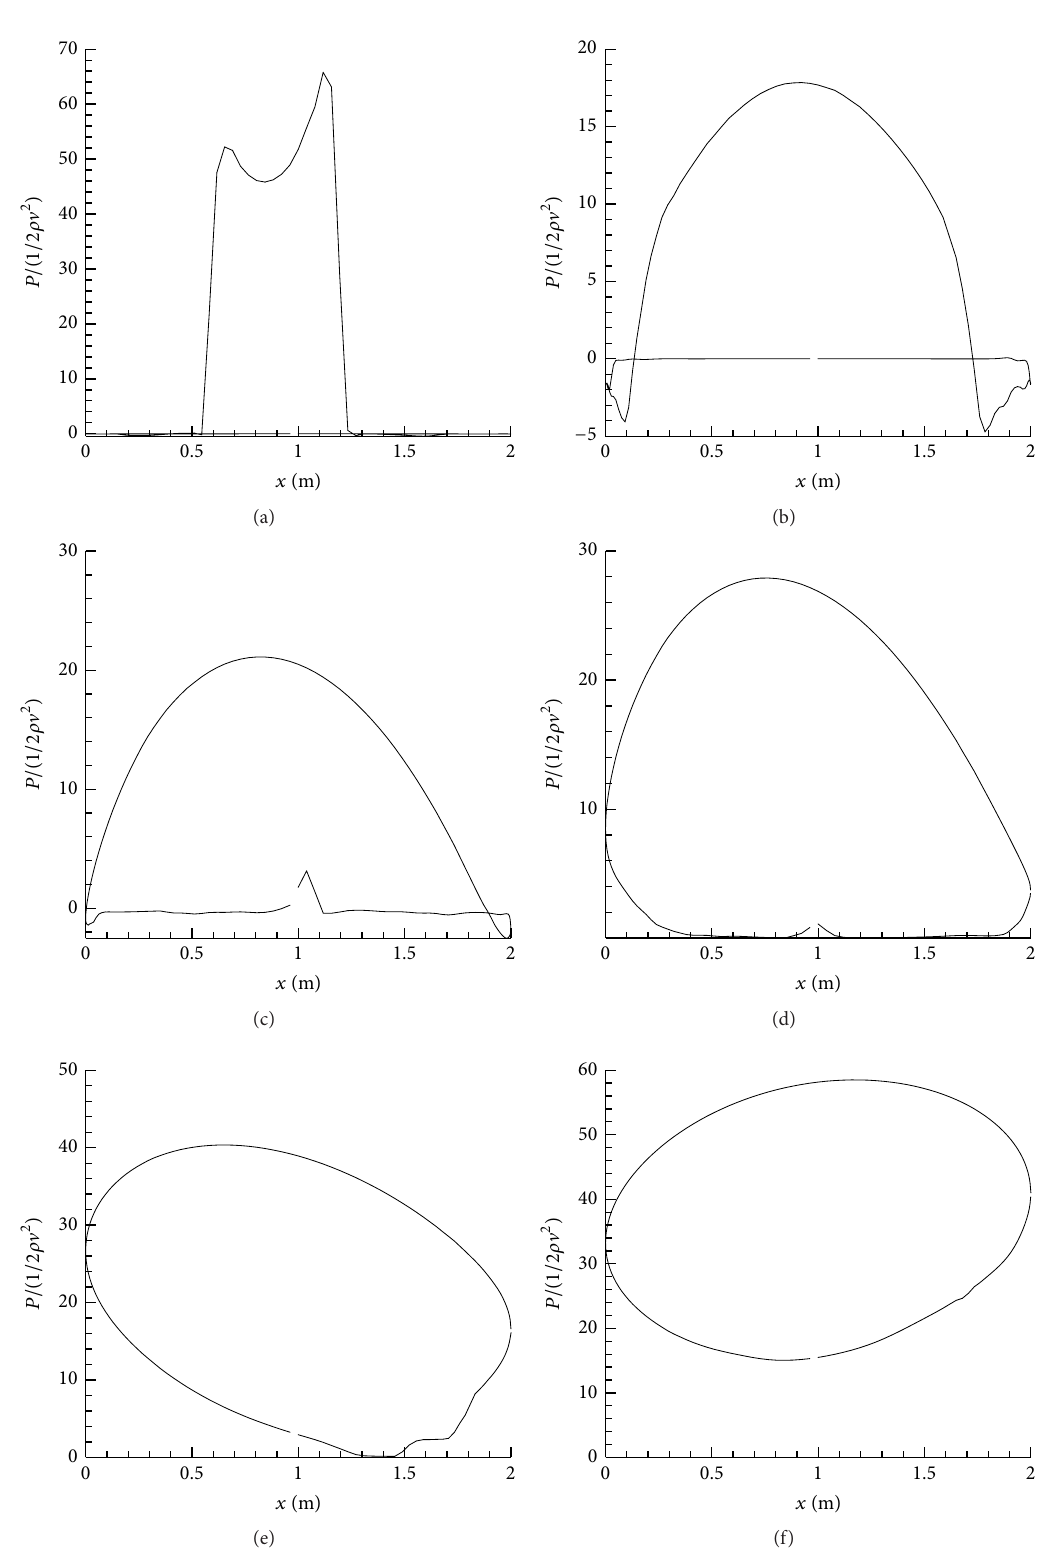
Figure 7: Pressure distributions on the cylinder: (a) 𝑇 = 0.75 ; (b) 𝑇 = 0.775 ; (c) 𝑇 = 0.84 ; (d) 𝑇 = 0.9 ; (e) 𝑇 = 1.1 ; (f) 𝑇 = 1.6